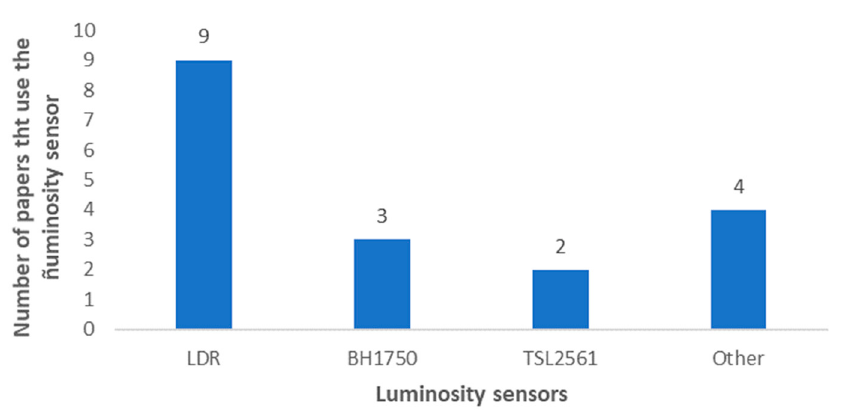
Figure 19. Most utilized luminosity sensors.